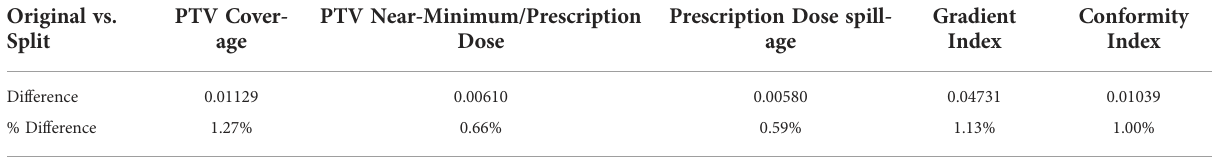
TABLE 2 Overall average and percentage differences between original and split treatment plans. Original vs.